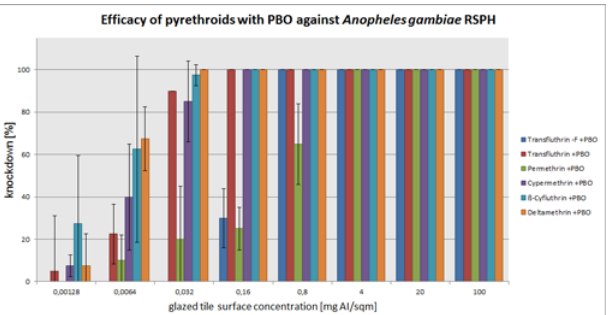
Fig 7. Arithmetic means and standard deviations of the 1 h results of a glazed tile contact bioassay using technical grade pyrethroids with PBO (1600 ppm) against the kdr- containing Anopheles gambiae RSP-H